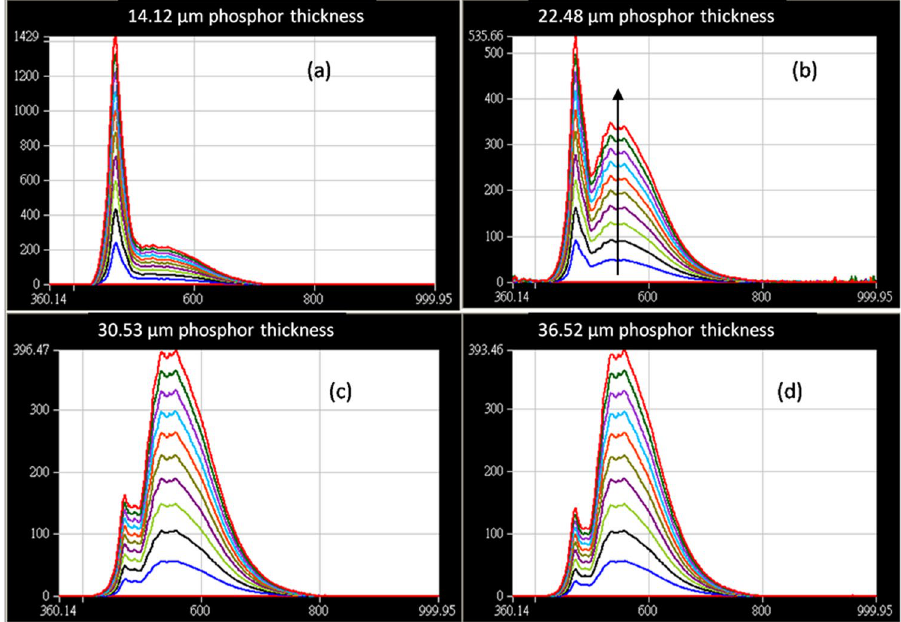
Figure 6. Emission spectra for the light output at different phosphor thickness ( a ) 14.12 μ m, ( b ) 22.48 μ m, ( c ) 30.53 μ m and ( d ) 36.52 μ m. The arrow in the figure indicates increasing drive current of the blue LED.